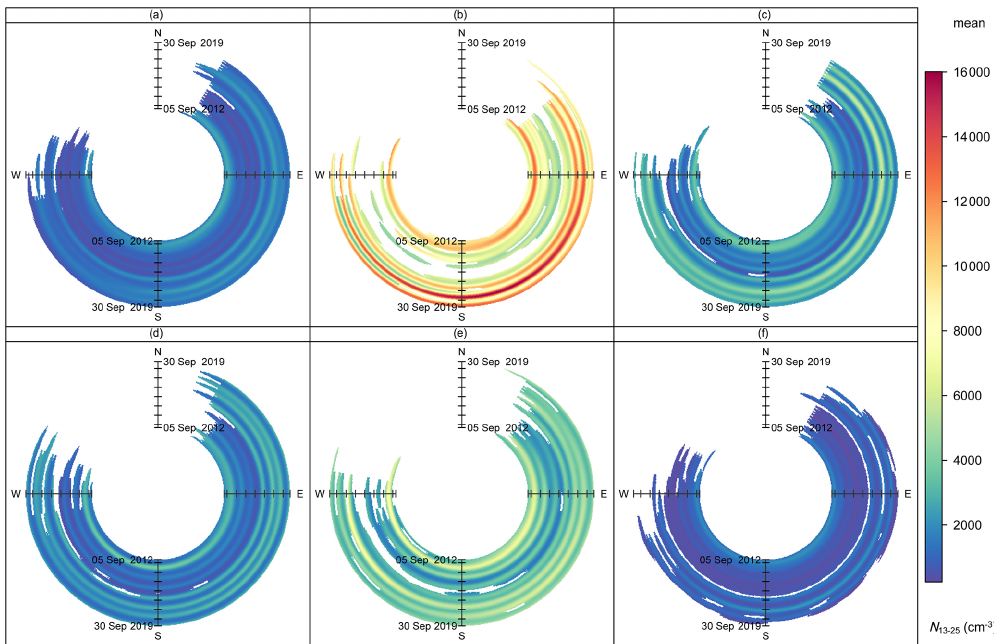
Figure 8. Trends of daily mean particle number in nucleation mode ( N 13 − 25 ) as wind directions for each cluster during the entire measure- ment